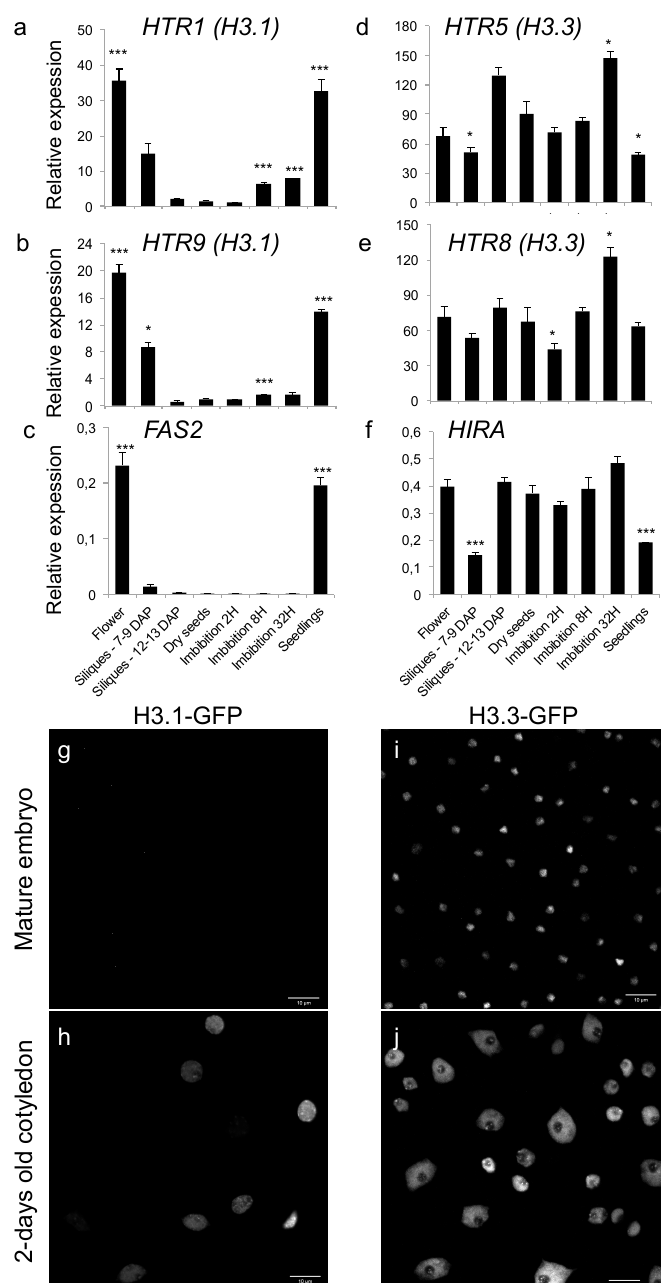
Figure 1. Chromatin in dry seeds is enriched in the replacement histone H3.3 variant. ( a – f ) Relative transcript levels of two genes encoding H3.1 ( HTR1 ( a ), HTR9 ( b )) and the middle subunit of the CAF-1 complex ( FAS2 ( c )), as well as two genes encoding H3.3 ( HTR5 ( d ), HTR8 ( e )) and the central subunit of the HIR complex ( HIRA ( f )) in flowers, siliques (7 to 9 and 12 to 13 days after pollination (DAP)), dry seeds and seeds imbibed for 2 hours (H), 8 h or 32 h as well as two-days-old seedlings. Transcript levels are normalized to MONENSIN SENSITIVITY 1 (MON1 , At2g28390 ). Error bars correspond to the standard error of the mean (SEM) of three biological replicates and statistically significant differences relative to dry seeds were determined using a two-sided Student’s t -test (* p < 0.05; *** p < 0.001). ( g – j ) Maximum intensity projections of confocal images of embryos 1 h after imbibition ( g , i ) and two-days-old cotyledons ( h , j ) of transgenic lines expressing H3.1-GFP ( g , h ) or H3.3-GFP ( i , j ).